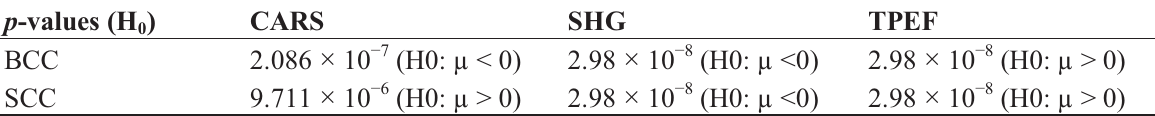
given in 0 − I neighbor tumor